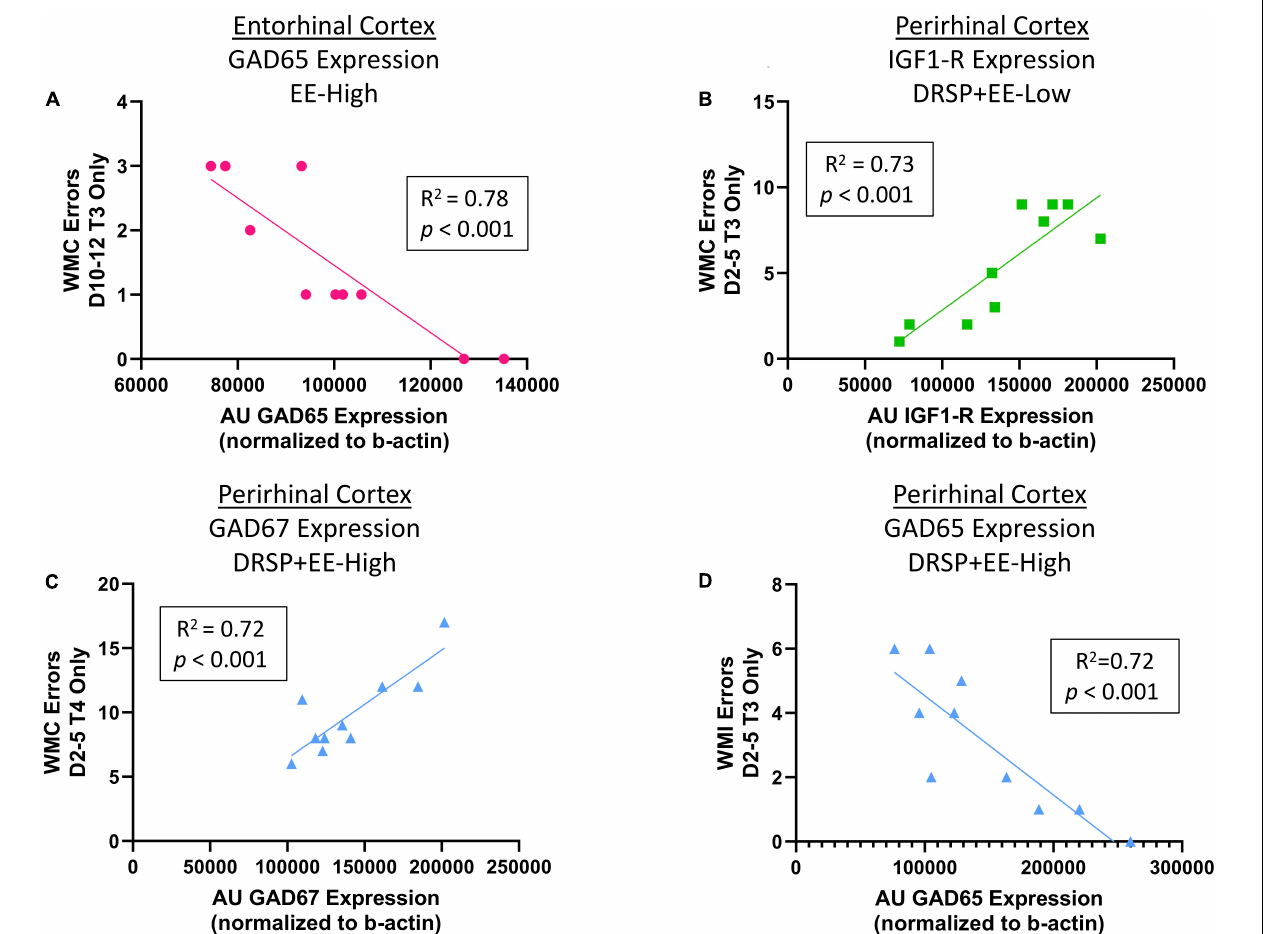
FIGURE 9 | Experiment 2 Correlations between proteins of interest and WRAM performance. (A) Within the EE-High group, greater GAD65 expression in the entorhinal cortex was associated with fewer WMC errors when working memory was moderately taxed during the Early Acquisition Phase of WRAM. (B) Within the DRSP + EE-Low group, greater IGF1-R expression in the perirhinal cortex was associated with more WMC errors when working memory was moderately taxed during the Early Acquisition Phase of WRAM. (C) Within the DRSP + EE-High group, greater GAD67 expression in the perirhinal cortex was associated with increased WMC errors on the maximum working memory load trial during Early Acquisition. (D) Within the DRSP + EE-High group, greater GAD65 expression in the perirhinal cortex was associated with decreased WMI errors on the moderate working memory load trial during Early Acquisition. Vehicle n = 10, DRSP n = 10, EE-Low n = 10, EE-High n = 10, DRSP + EE-Low n = 10, and DRSP + EE-High n =